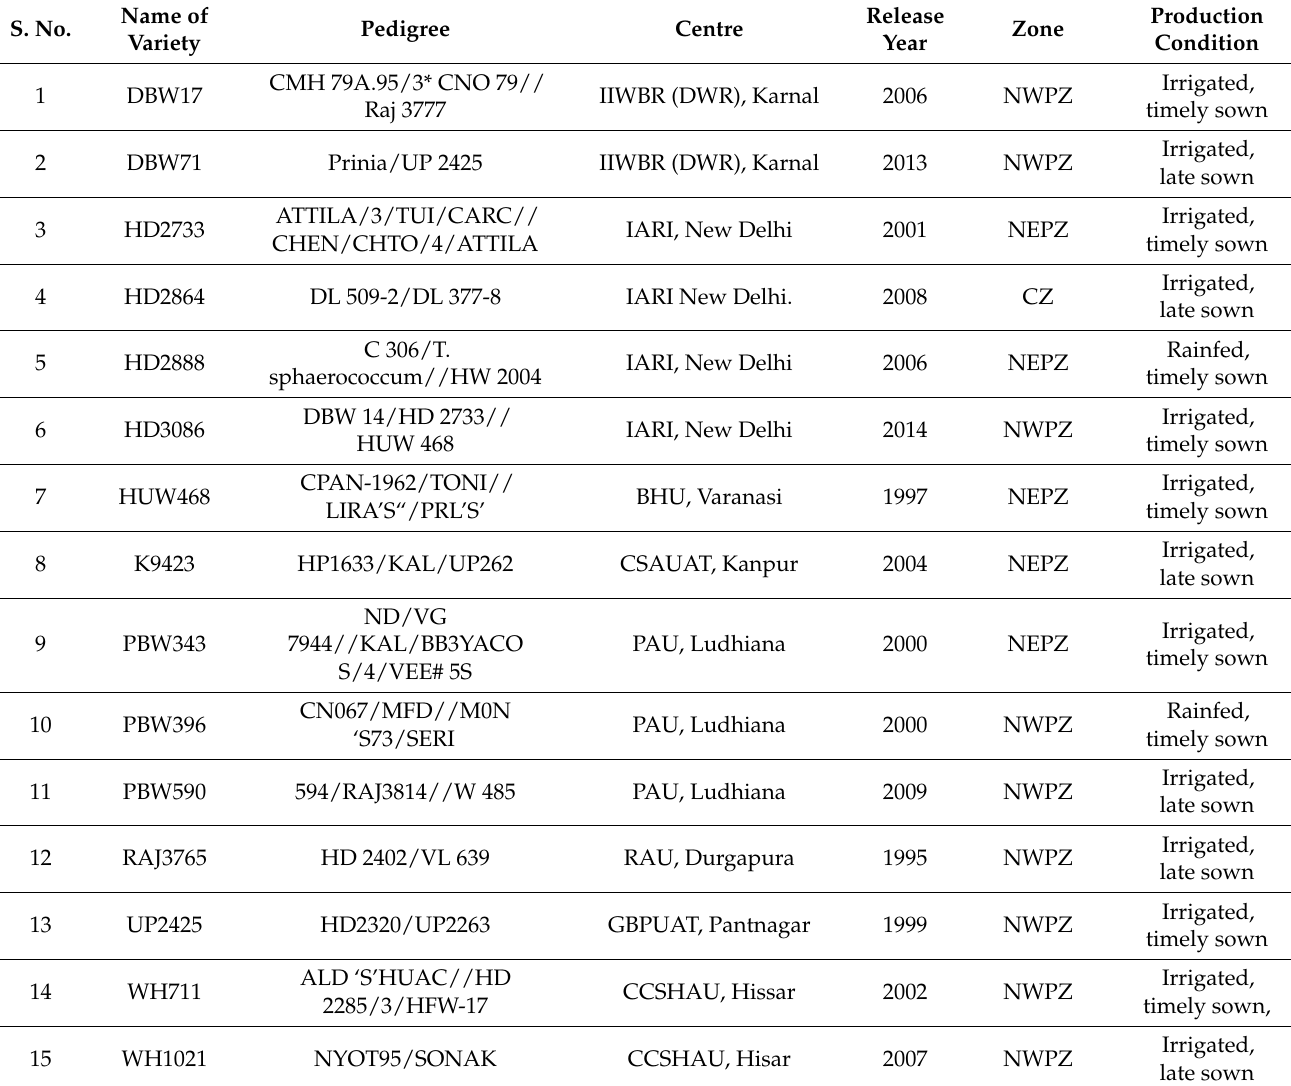
Table 1. Details of fifteen